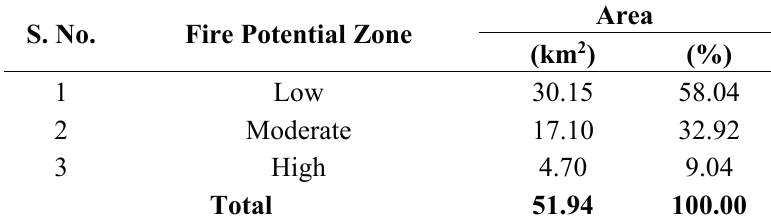
Figure 7. Fire Potential Zonation map of Kathmandu Metropolitan City. Table 6. Area distribution of fire potential zone in Kathmandu Metropolitan